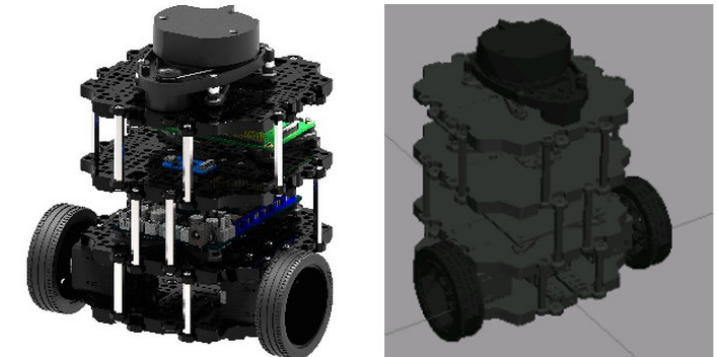
Figure 19. The real and simulated model of Turtlebot3 Burger.